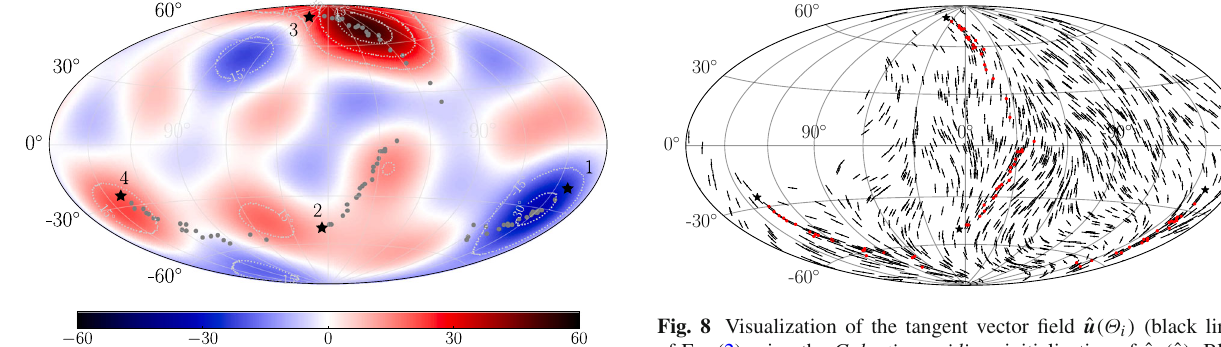
Fig. 8 Visualization of the tangent vector field ˆ u (Θ i ) (black lines) of Eq. (2) using the Galactic meridians initialization of ˆ u 0 ( ˆ r ) . Black star symbols show the simulated source directions while the red circular symbolsmarkthe N s = 20eventspersourcewhichhavebeendisplaced by the JF12 model without simulated GMF